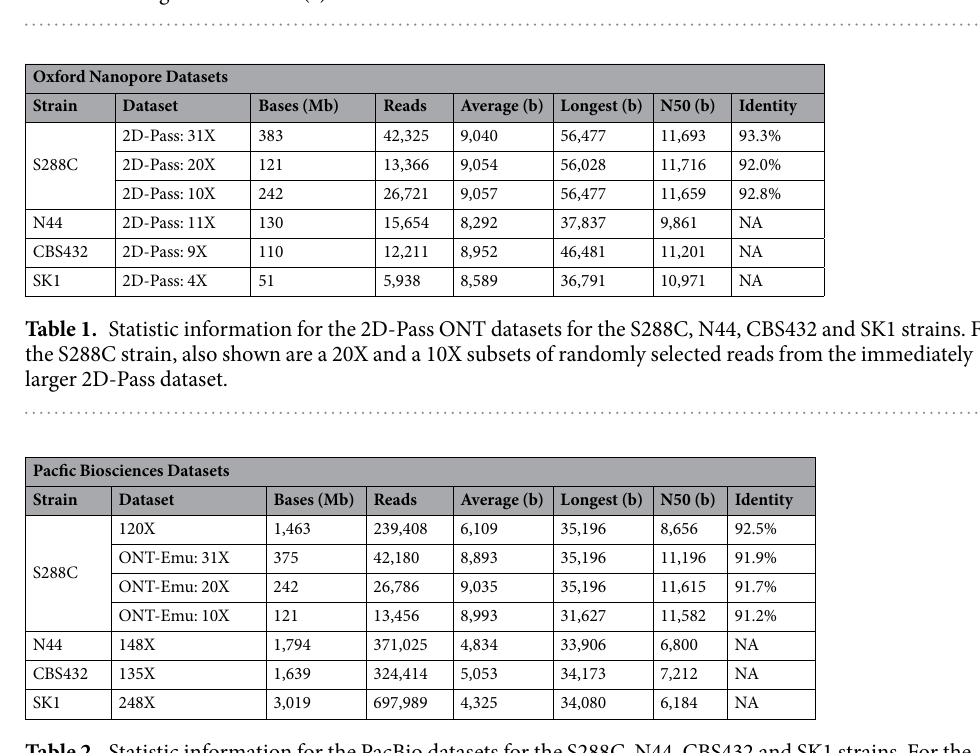
Figure 1. Read length distributions for the ONT and PacBio datasets. Read length distributions for the four yeast strains, S288C, N44, CBS432 and SK1 of the 2D-Pass ONT datasets in ( a ) and the PacBio datasets in ( b ). Comparison of read length distributions for the S288C strain of the 31X datasets ONT 2D-Pass and PacBio ONT-emulating 31X-subset in ( c ).